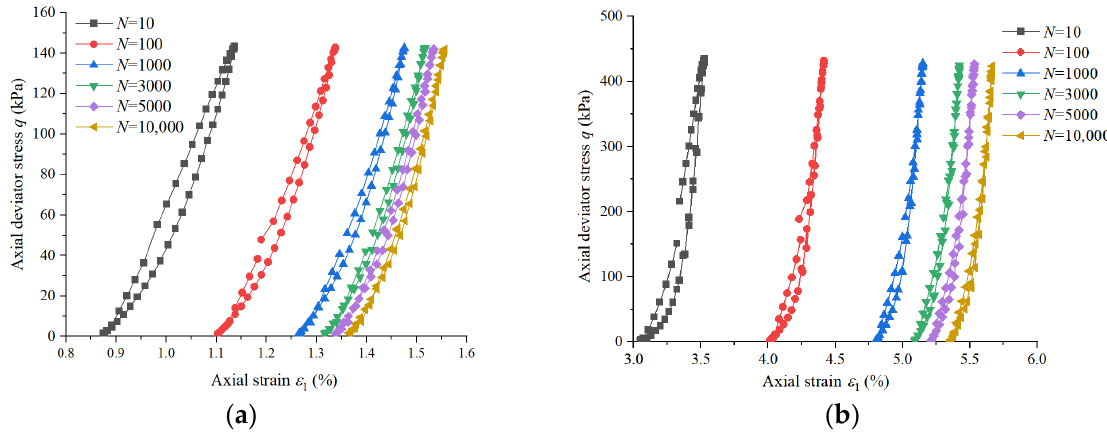
Figure 12. Stress–strain hysteresis loop of samples with different CSR : ( a ) CSR = 0.23; ( b ) CSR = 0.72.